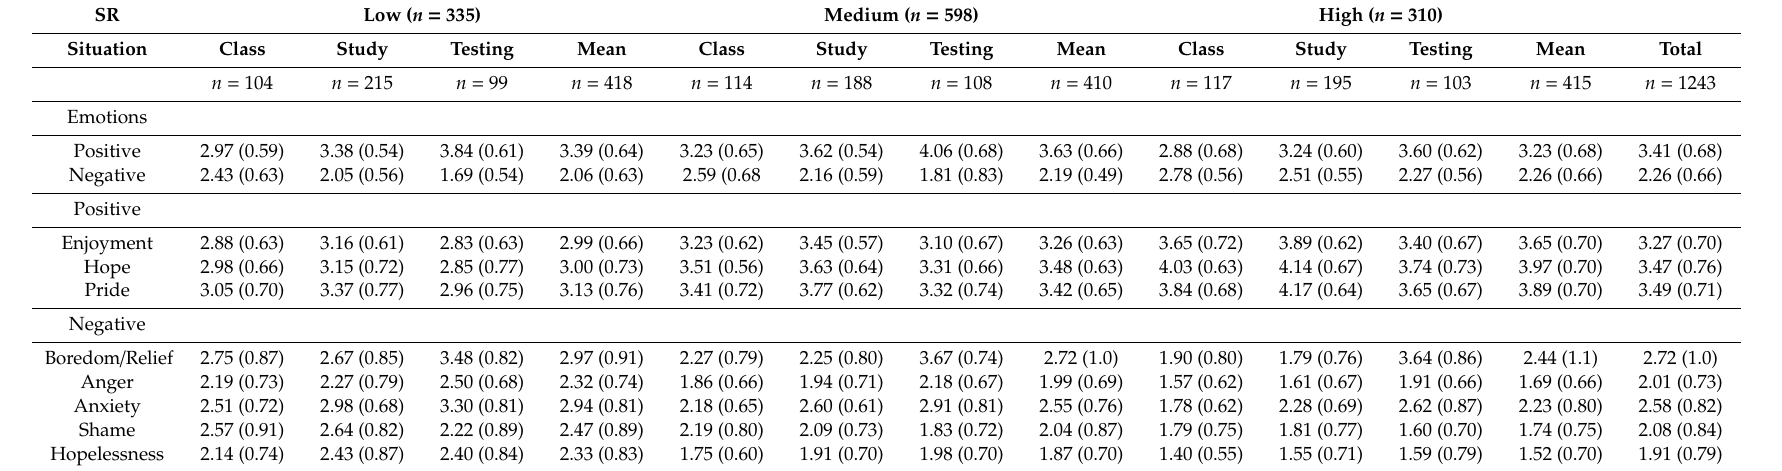
Table 5. Level of academic emotions according to the Self-Regulation level and